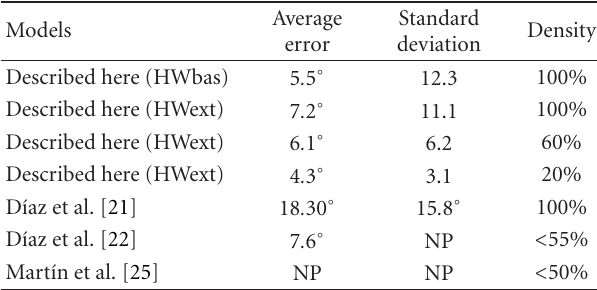
Table 4: Summary of the di ff erent implementations for the Yosemite sequence. NP means not